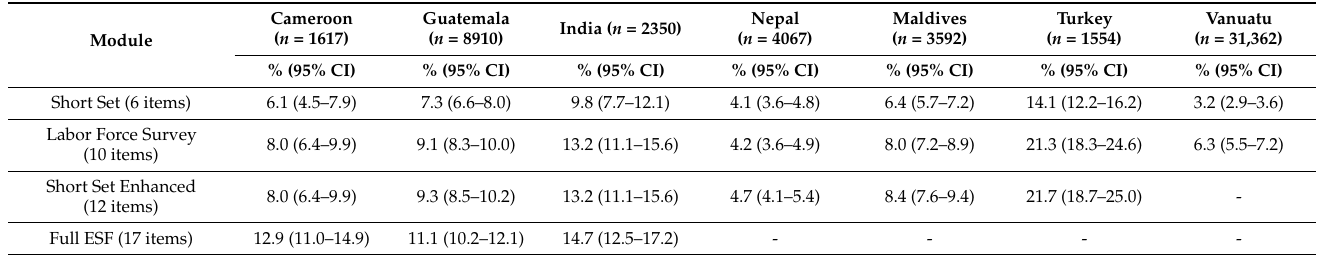
Table 3. Disability prevalence by module type—Standard threshold.